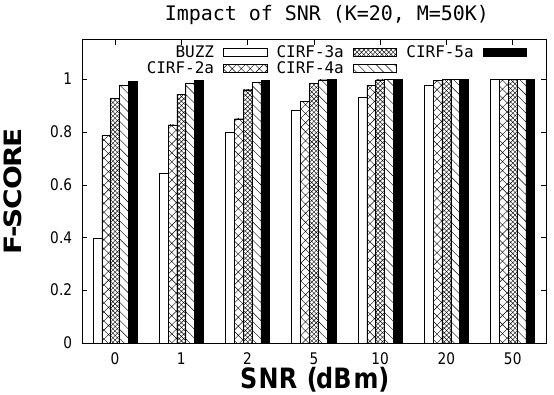
Figure 4. F-score with varying